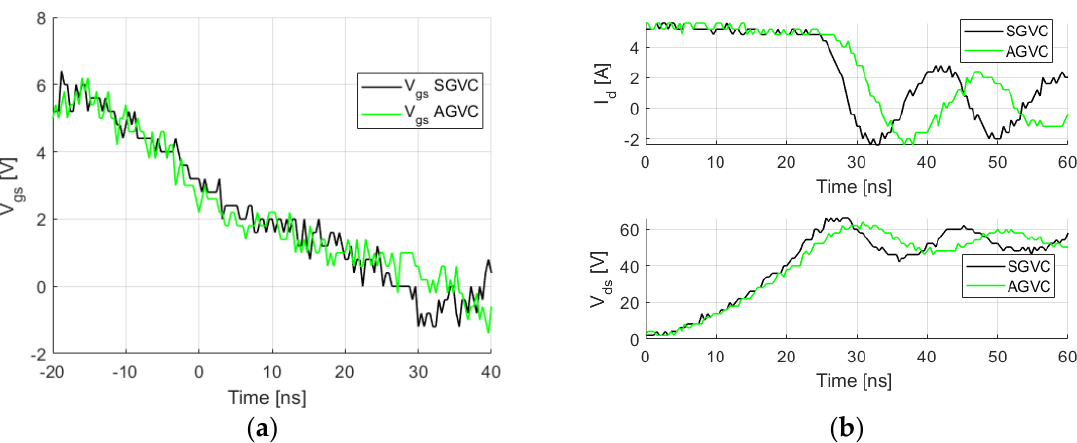
Figure 19. Simulated control signal of the driver (V gderiv ) during GaN transistor turn-off.